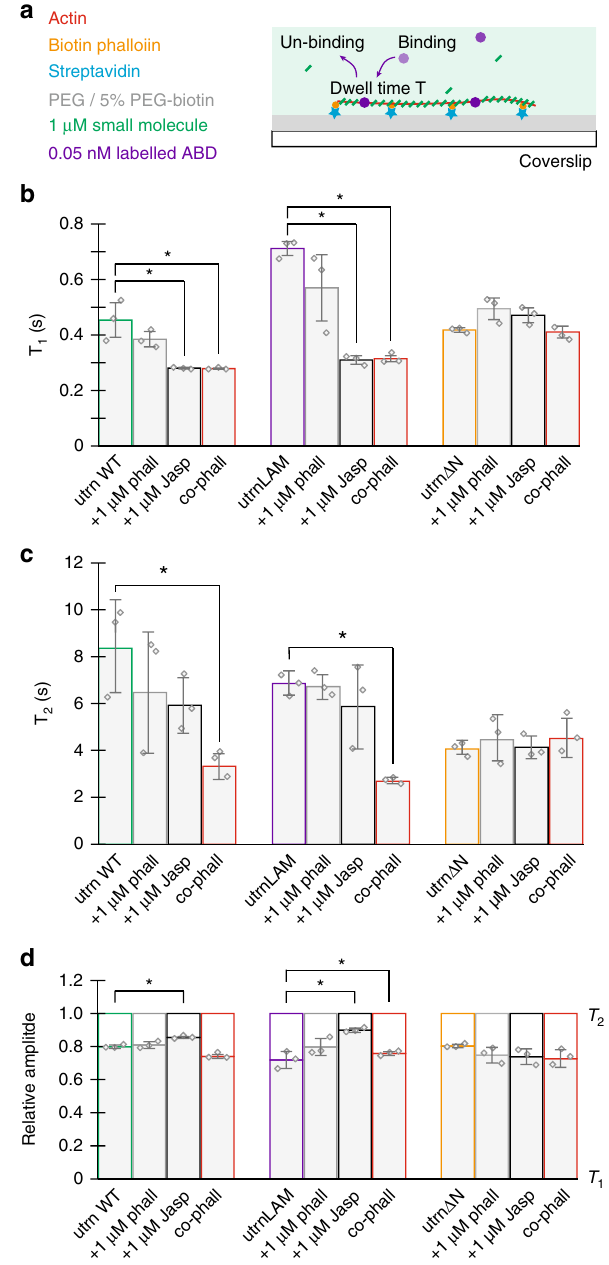
Fig. 3 Filament stabilization by small molecules alter utrophin ABD mutant dwell times. a Measurement of binding dwell times in the presence of phalloidin and jasplakinolide that stabilize actin fi laments. Either 1 µ M phalloidin or 1 µ M jasplakinolide were added to the assay chamber after actin fi laments had been tethered to the glass coverslip. These conditions were also compared with actin fi laments co-polymerized with 5 µ M biotin-phalloidin which were subsequently added to the imaging chamber. b Comparisons of the fi rst timescale, c second timescale, and d relative amplitudes from a double exponential fi t to the cumulative distribution functions for the different constructs and conditions. Error bars are the standard deviation around the mean of 3 technical replicates. Conditions were compared using a two-tailed students t -test, with p <0.05 denoted by a star